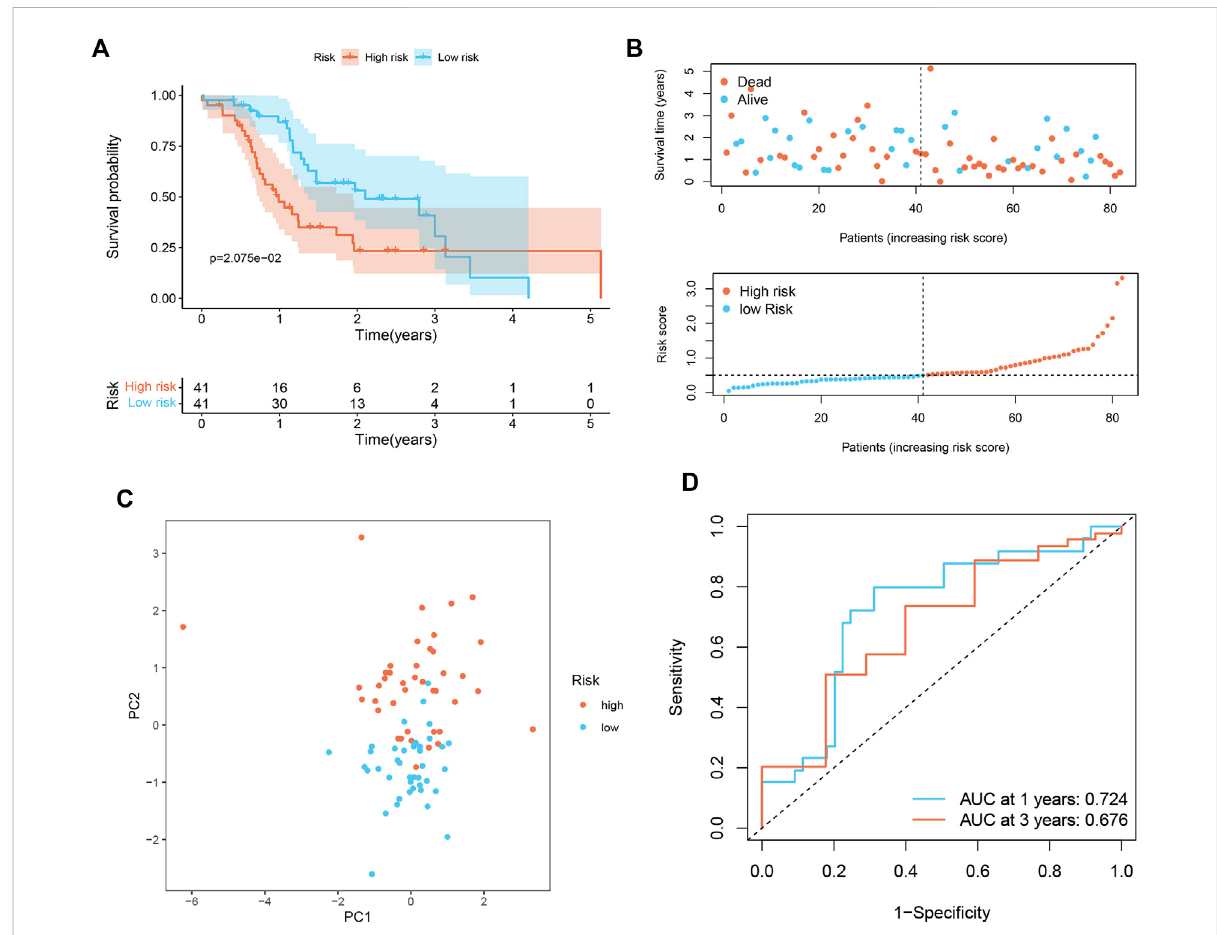
FIGURE 3 Validation ofsenescence-associatedsignature inICGC cohort( n =82). (A) Kaplan-Meier analysis ofOS amongdifferentsubgroups. (B) Survival status among tworisk subgroups and riskscore distribution. (C) PCA analysis distinguished betweenhigh- andlow-riskscore groups. (D) ROC curve evaluates the prediction accuracy of risk